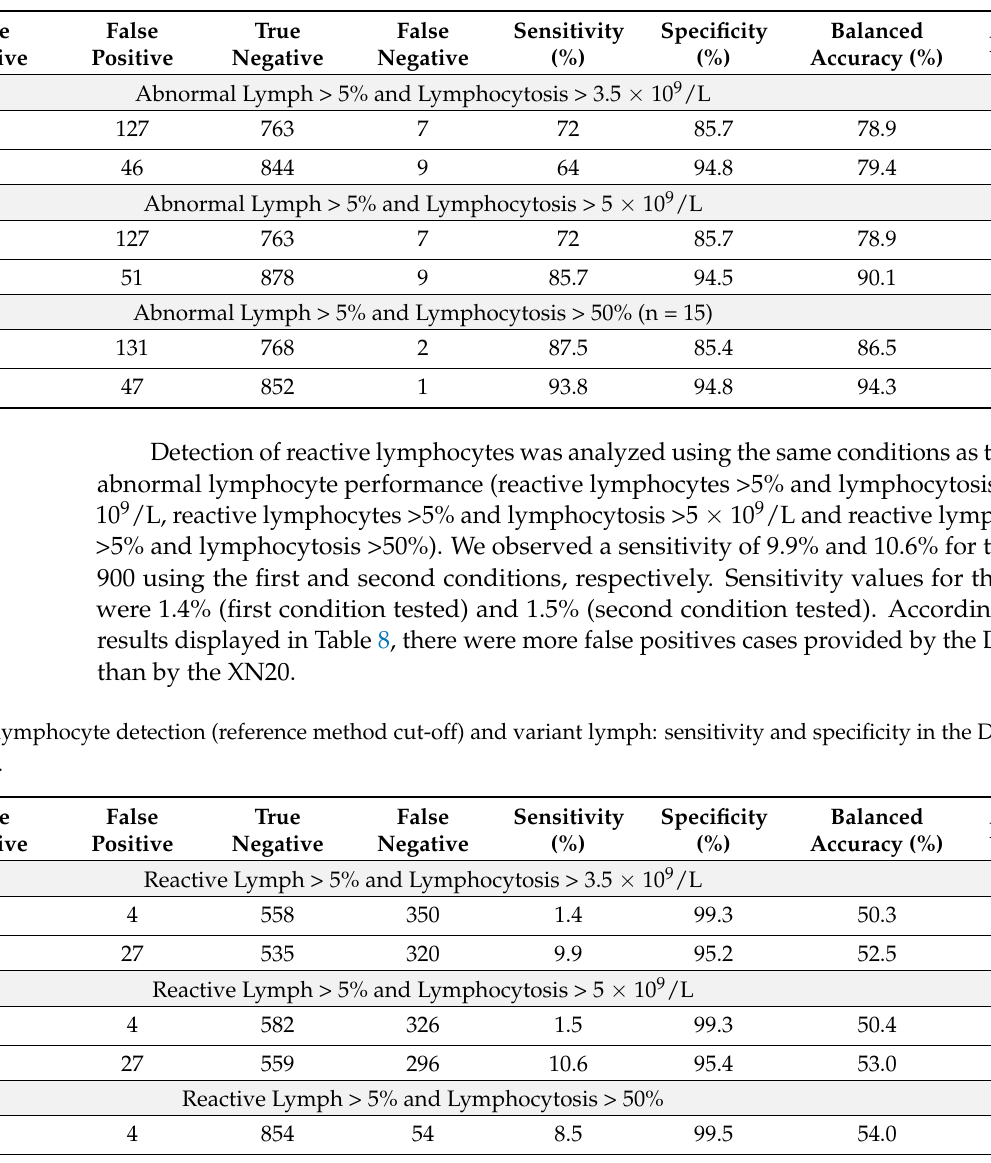
Table 7. Abnormal lymphocyte detection (reference method cut-off) and variant lymph: sensitivity and specificity in the DxH 900 and the X20N.